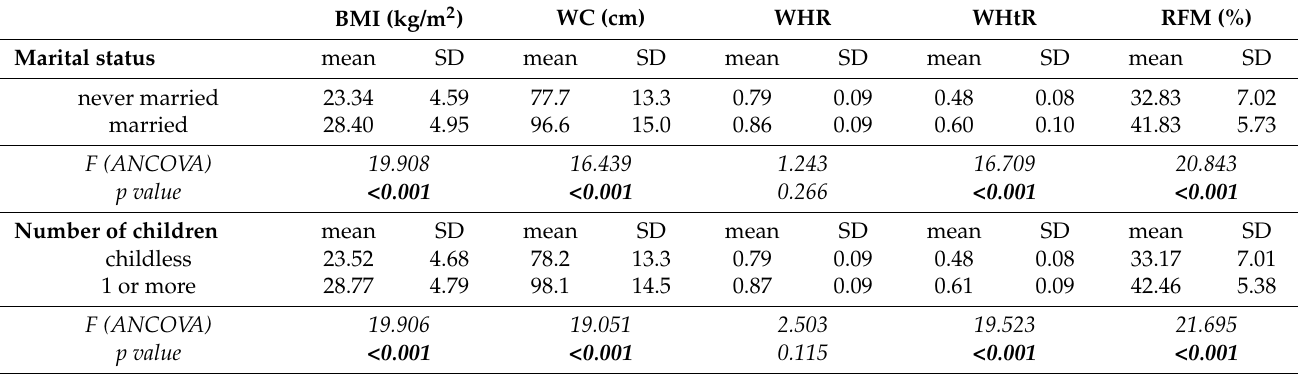
Table 5. Anthropometric indicators of metabolic syndrome risk by socio-demographic and PA variables ( n =